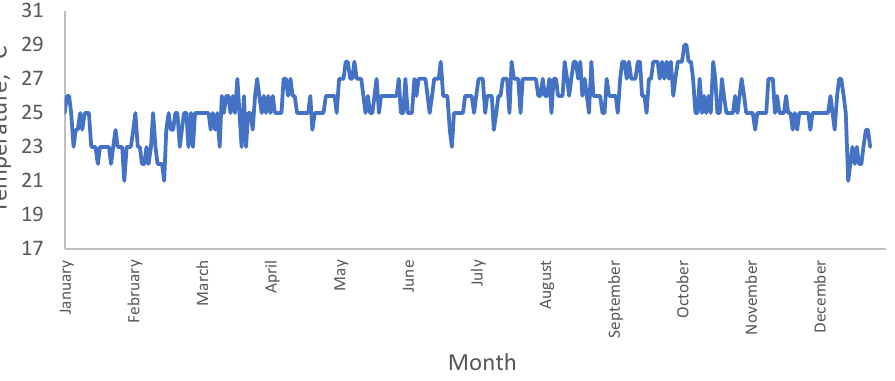
Figure 1. The ambient temperature in Pangalengan, West Java, Indonesia in 2018 [30].